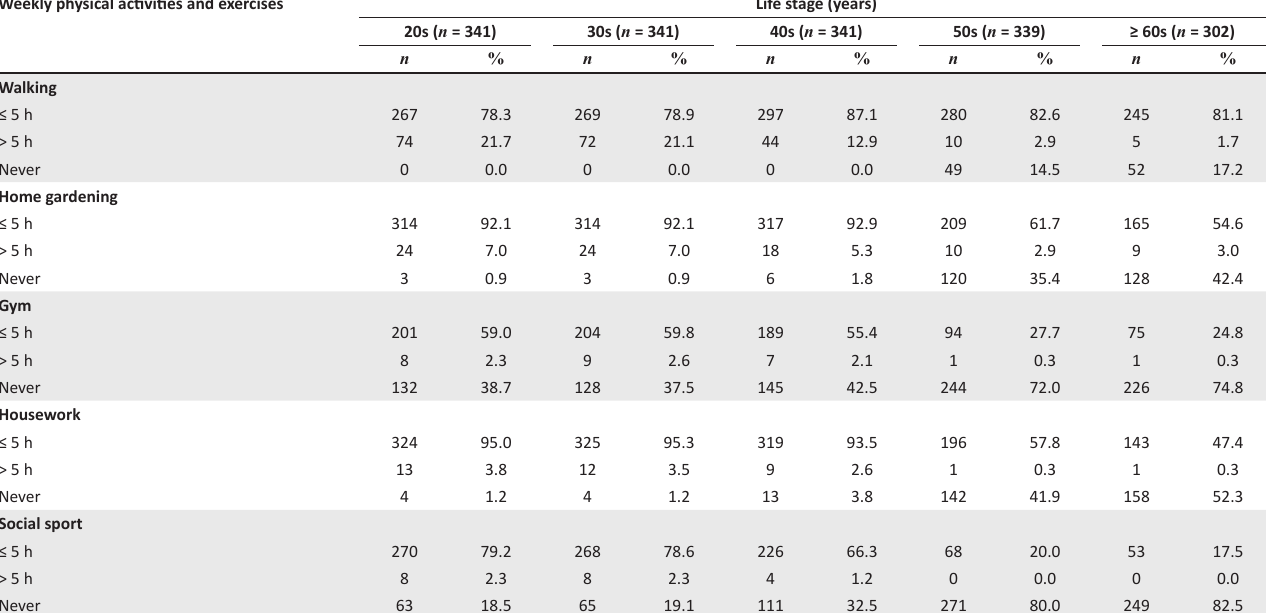
TABLE 3: Weekly physical activities and